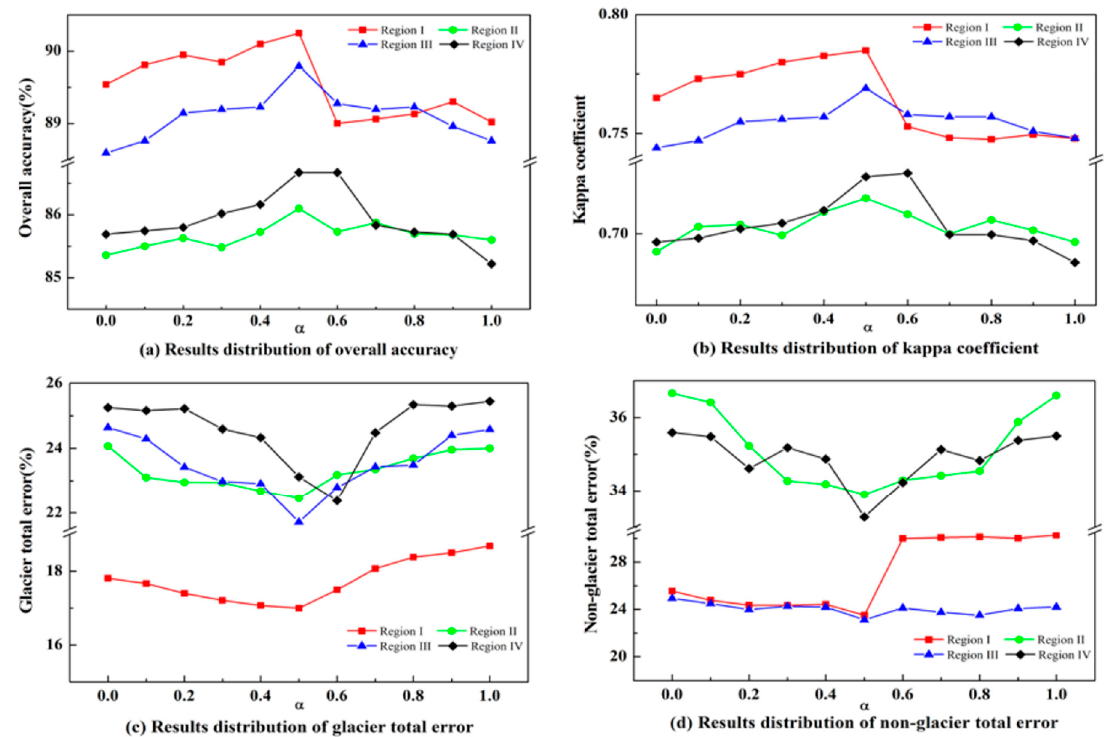
Figure 7. Distribution of the four accuracy measures ( a – d ) calculated by the automated glacier extraction index (AGEI) with different α in the four regions.